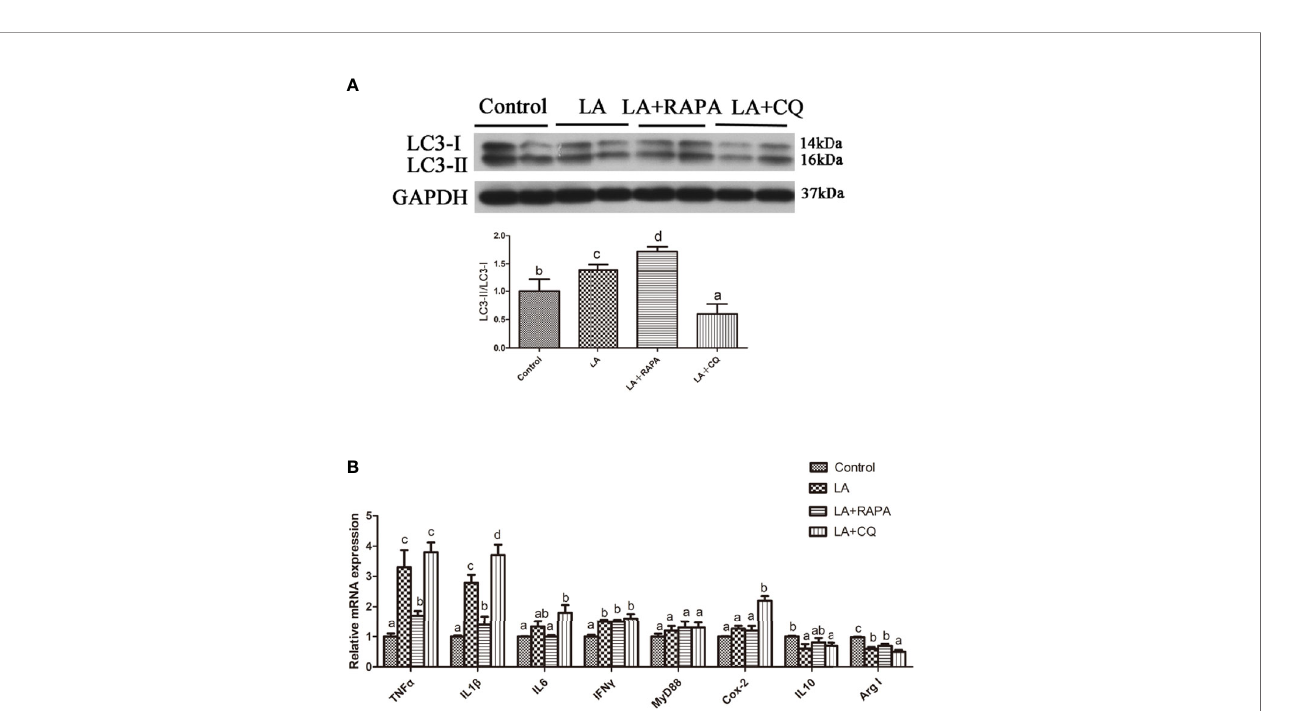
FIGURE 6 | Autophagy could reduce LA-induced in fl ammatory in vitro . (A) The ratio of LC3-II/LC3-I was analyzed by western blots in primary hepatocyte after treatment of BSA, LA, LA+RAPA and LA+CQ (n=3). BSA group as a negative control. (B) The mRNA expressions of TNF a , IL1 b , IL6, IFN g , MyD88, Cox-2, IL10 and Arg I were analyzed by qRT-PCR in primary hepatocyte after treatment of BSA, LA, LA+RAPA and LA+CQ (n=6). Results were represented as means with SEM and signi fi cance was evaluated by one-way ANOVA followed by Tukey ’ s multiple range tests ( P < 0.05). a,b,c Means share a same superscript letter are not signi fi cantly different ( P ≥